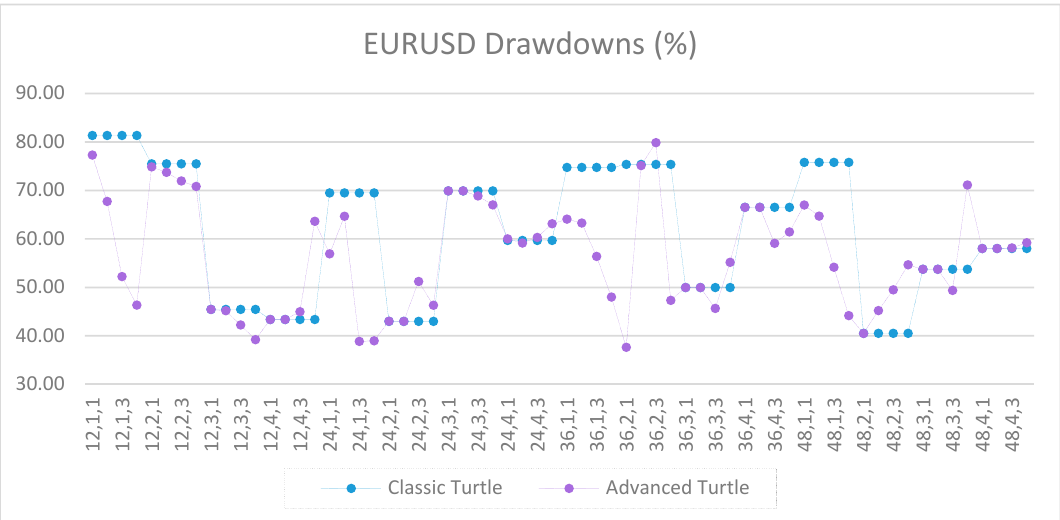
Figure A35. Net profits of EURUSD between the classic and the advanced Turtle systems for every combination of N, X, Y for the slow parameters (80, 160).